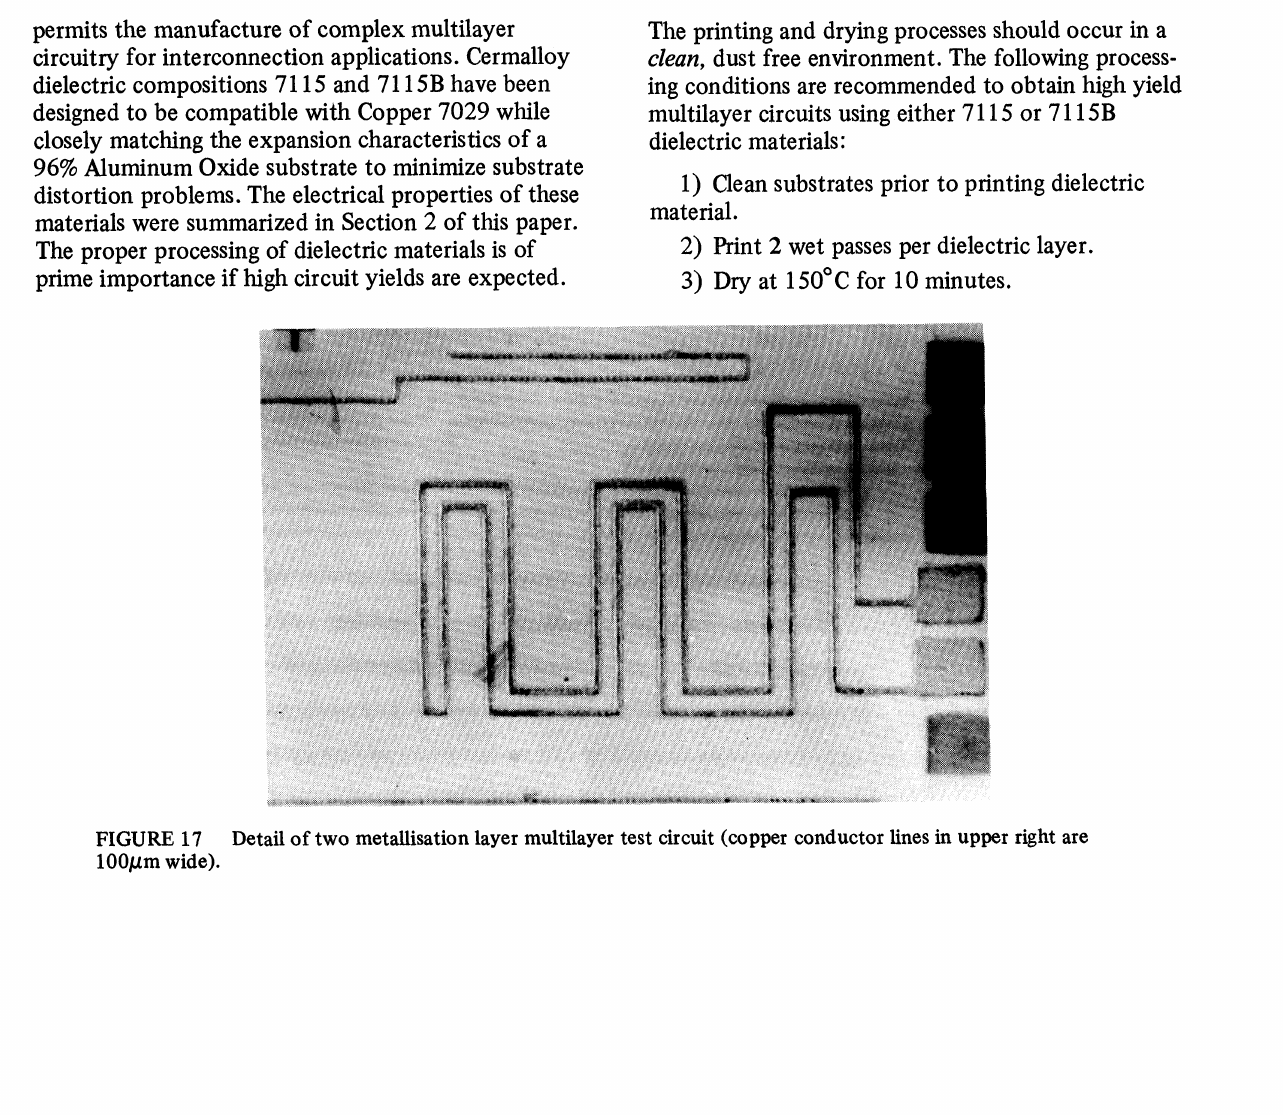
FIGURE 16 Two metallisation layer multilayer test circuit (for magnification see Figure